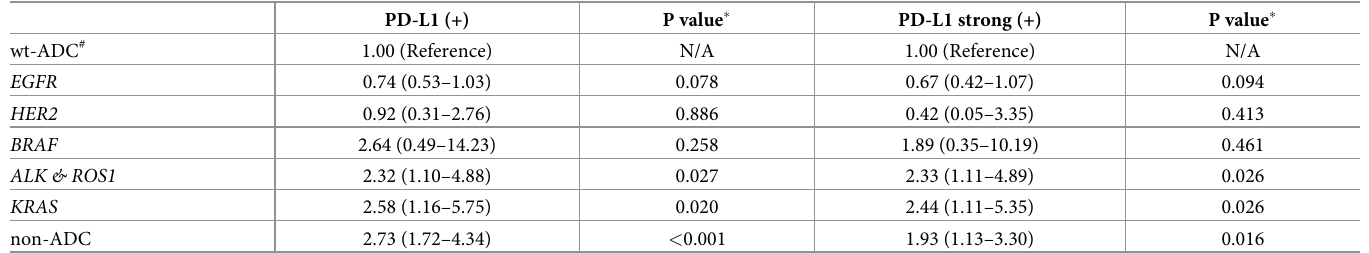
Table 3. Impact of driver mutation status on the PD-L1 expression.